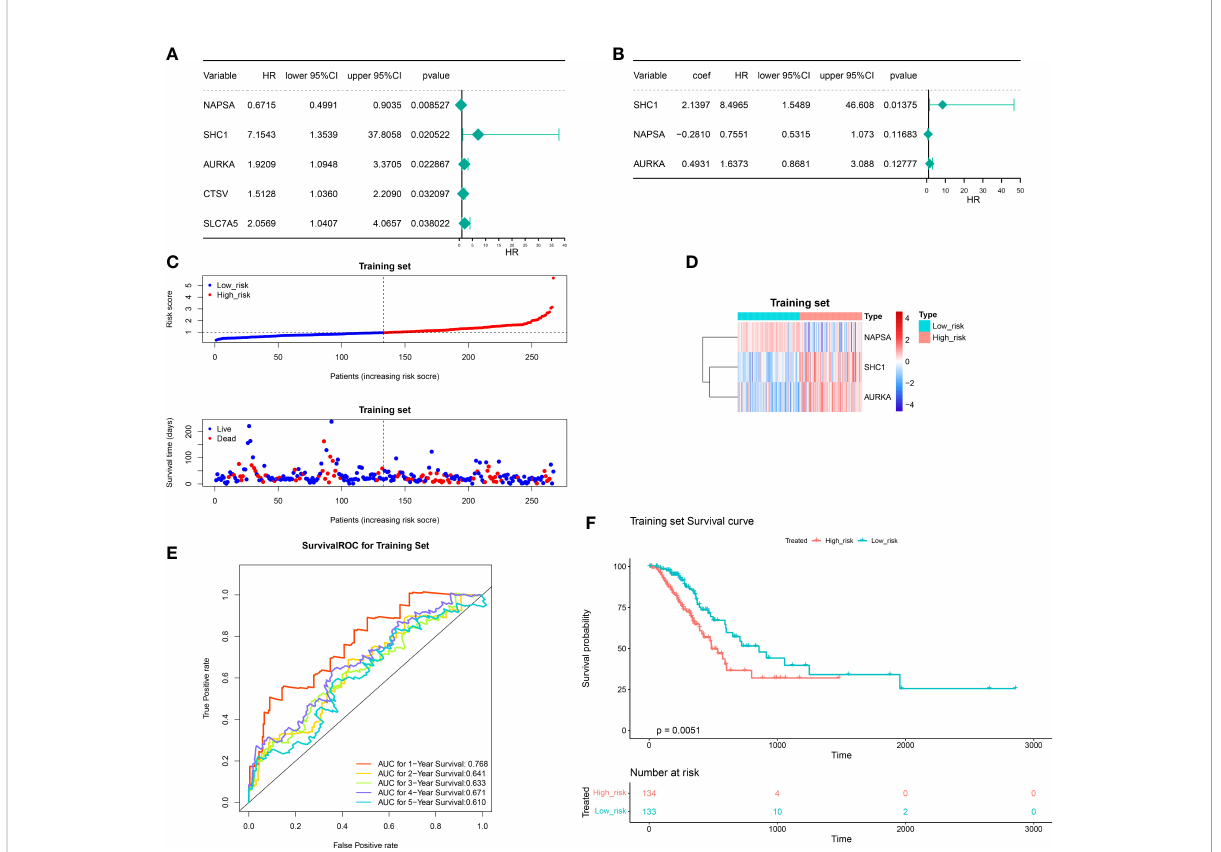
FIGURE 4 Construction of the autophagy-related risk score model. (A) Univariate forest plot of the correlation between the expression of DERRAGs and the overall survival of LUAD patients. (B) Multifactorial forest plot of the correlation between expression of DERRAGs and overall survival of LUAD patients. (C) The validation set high and low-risk group curves. (D) Heat map of model gene expression in the high and low-risk groups in the training set. (E) Training set survival ROC curve. (F) KM survival curves for the high and low-risk groups in the training